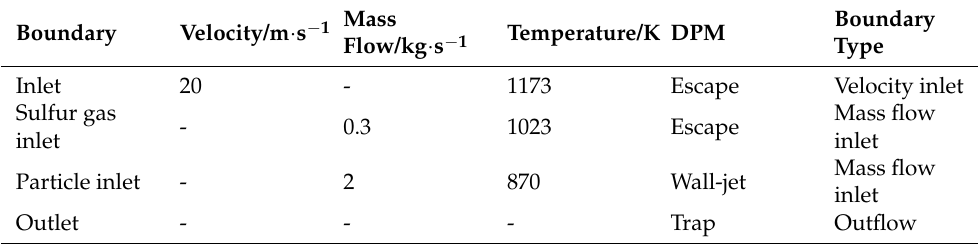
Table 3. Parameter setting of each boundary